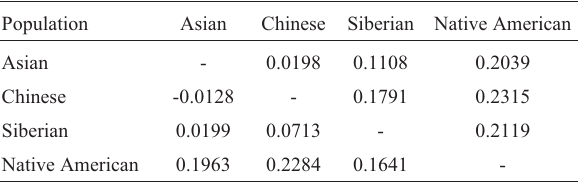
Table 2 - Average pairwise (cid:2) ST (lower diagonal) and their standard devia- tions over loci (upper diagonal). Population